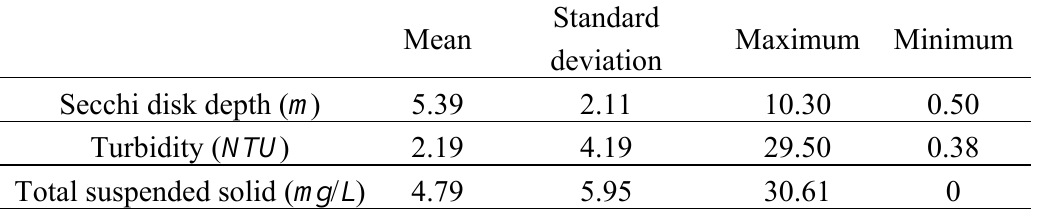
Table 2. Statistical properties of water quality